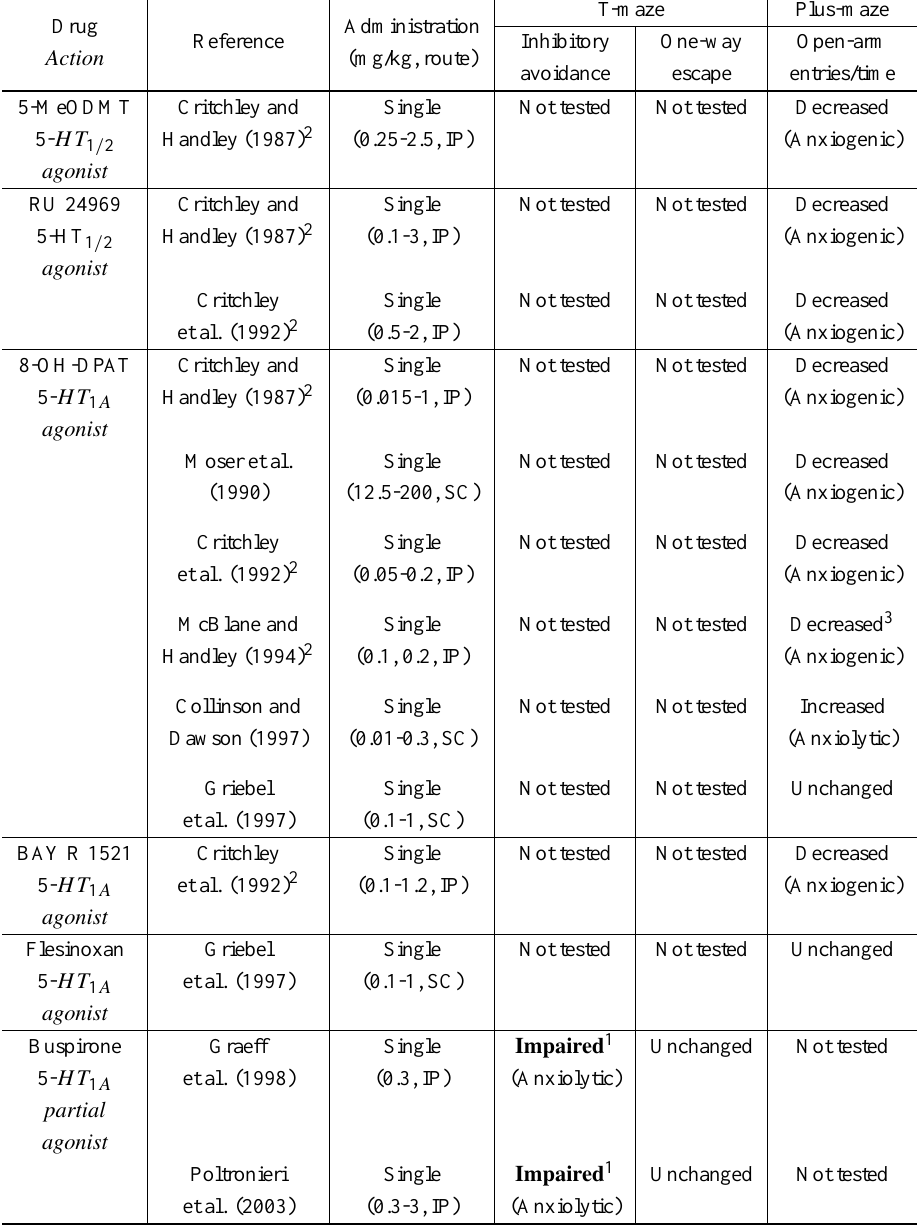
Comparative effects of 5-HT receptor ligands on rat behavior in two elevated